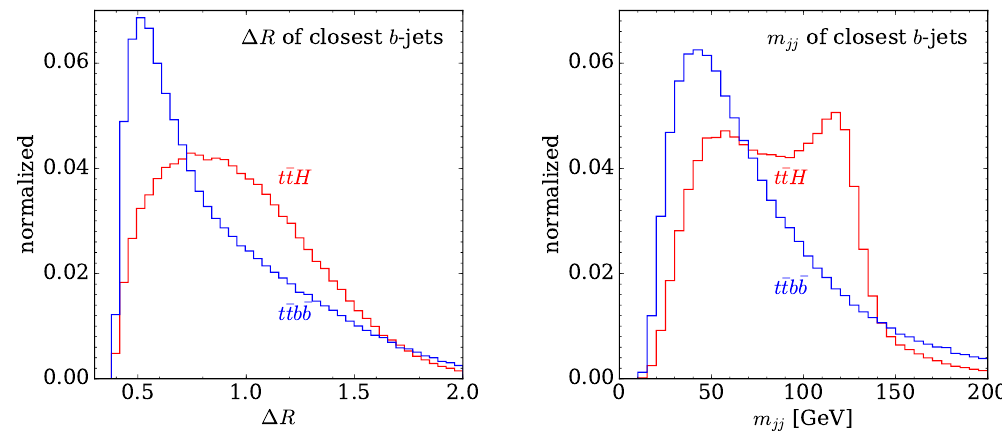
Figure 13: Left: minimum ∆ R of these two closest b